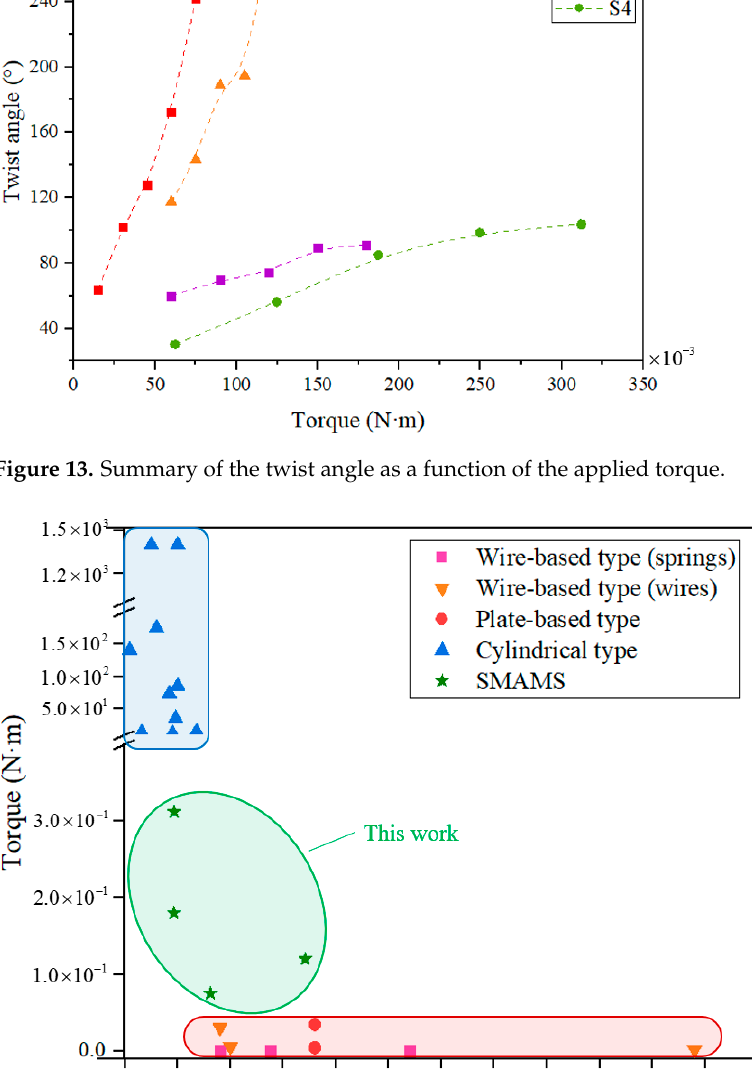
Figure 13. Summary of the twist angle as a function of the applied torque.